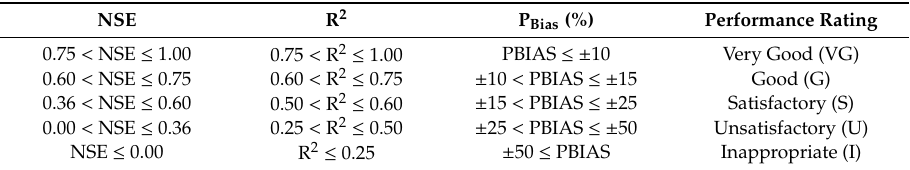
Table 5. General performance ratings.